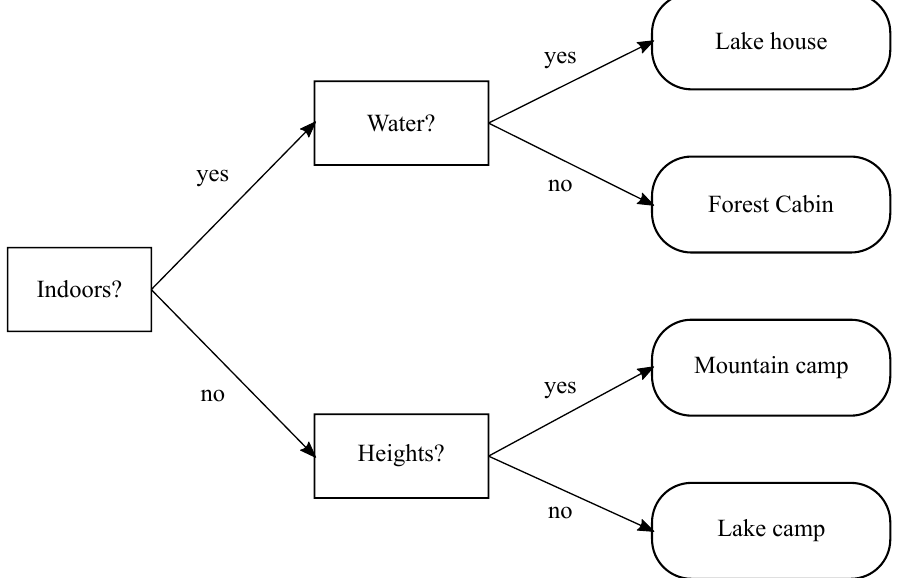
Figure 6. Decision tree used by the environment